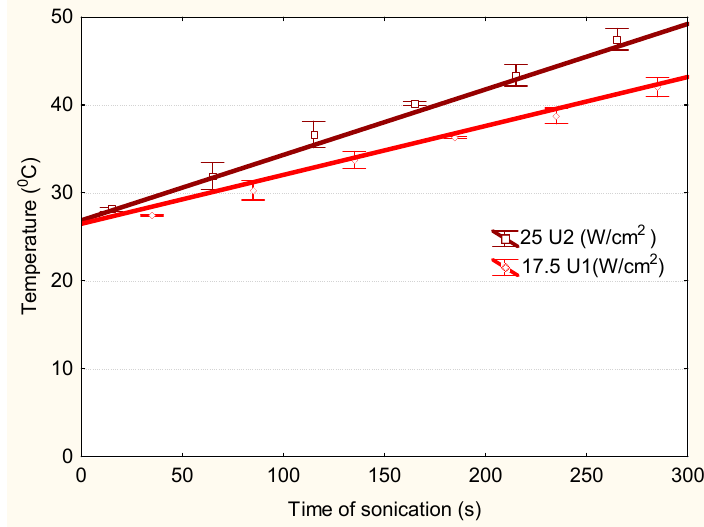
Figure 2. Influence of sonication time on temperature of apple juice. Error bars represent standard deviations.